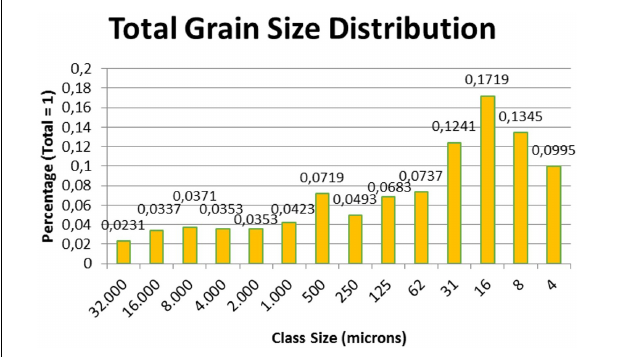
FIGURE 3 | Reconstructed Total Grain Size Distribution (TGSD) for a typical rhyolitic Plinian fall deposit (adapted from Stevenson et al., 2015) used for the synthetic scenario. Important to note that no accretionary lapilli have been identified in the AD 1362 fall deposit (Thorvaldur Thordarson pers. com.